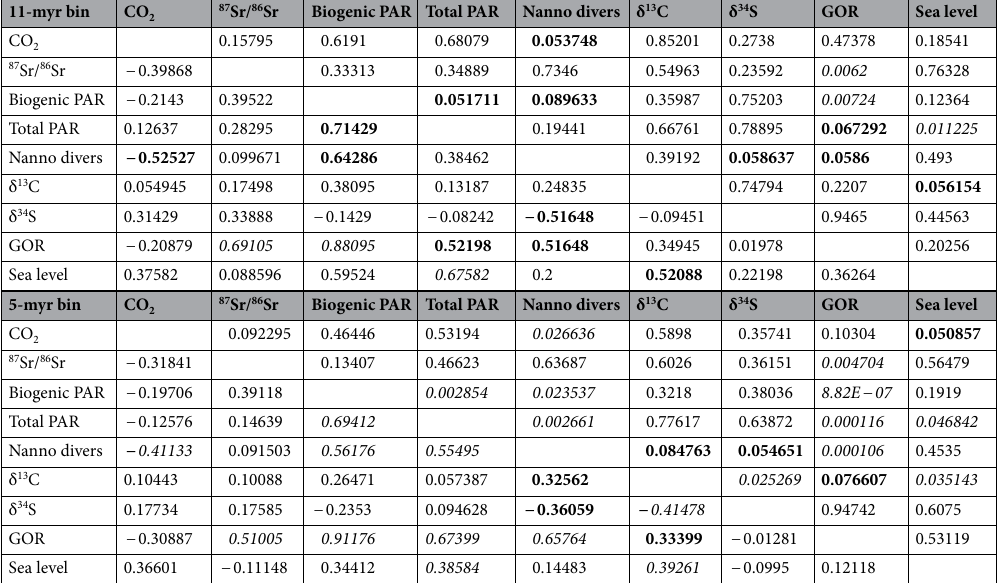
Table 1. Comparison of correlations of uncorrected data*. * Data not corrected with Bonferroni correction (see Methods). Upper half of each binning method (above diagonally-arranged blank boxes): p (uncorrelated); lower half: Spearman’s correlation coefficient (ρ). Italics: significant correlations ( p < 0.05); boldface: marginal correlations discussed in